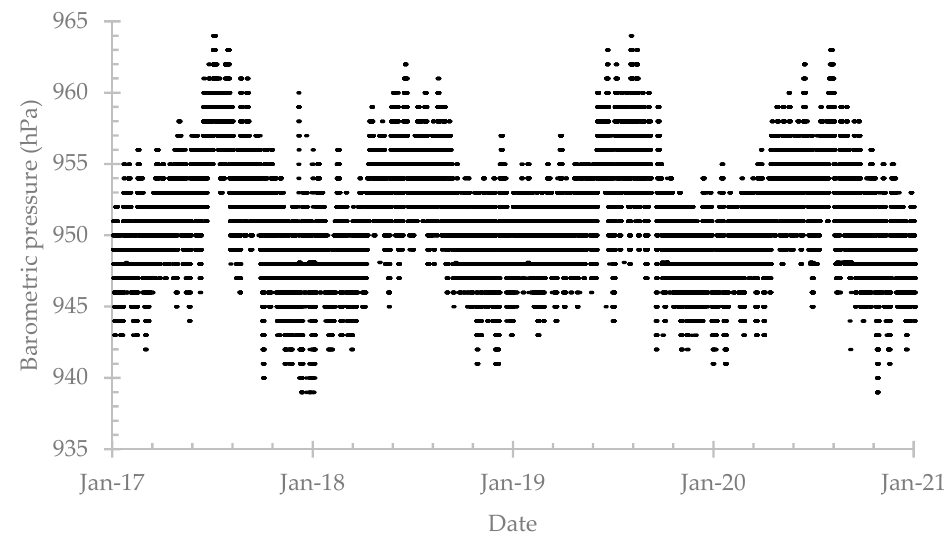
Figure 2. Range of values and natural fluctuations of barometric pressure (hPa) at Piracicaba (S ã o Paulo state, Brazil), from January 2017 to December 2021, used as a historical dataset for defining the operational requirements of the barometric chamber.